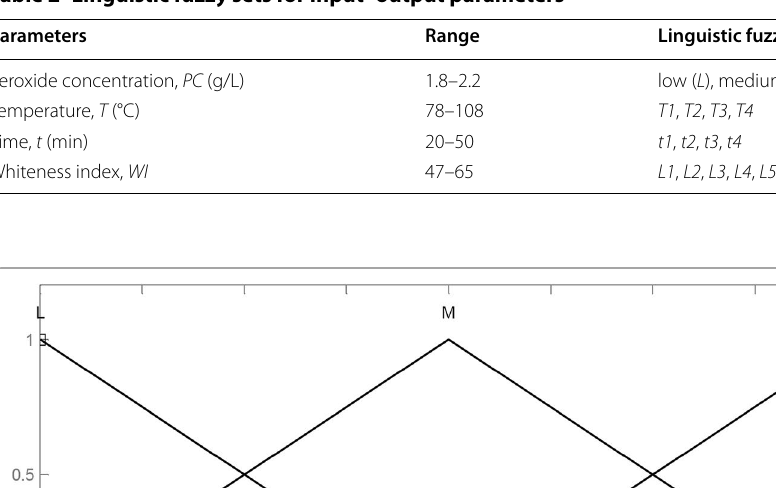
Table 2 Linguistic fuzzy sets for input–output parameters